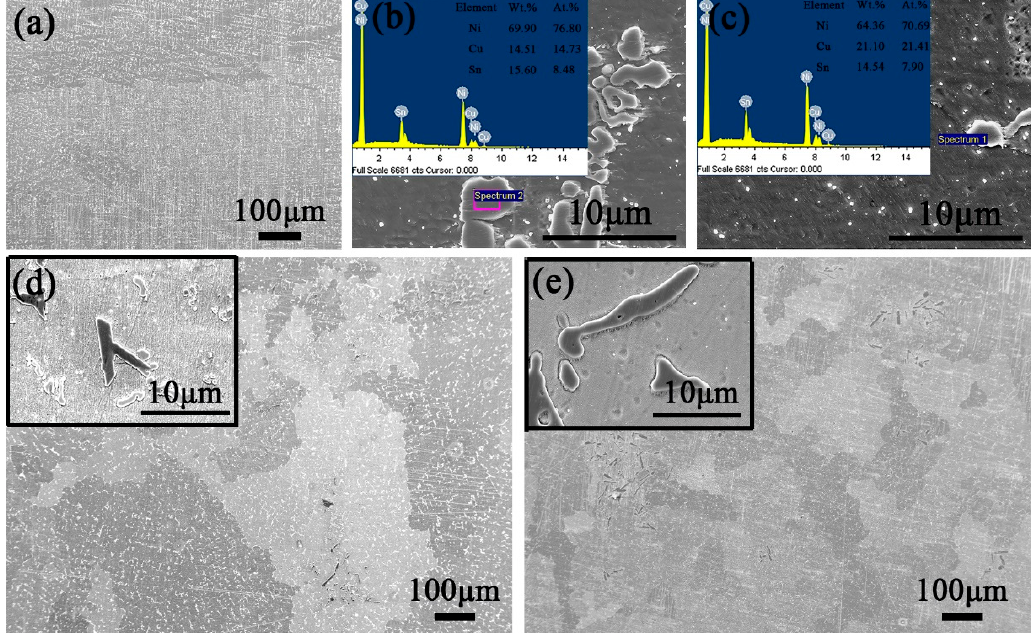
Figure 9. The SEM images of solid solution microstructure for Cu–15Ni–8Sn–xMo alloys with dif- ferent Mo content: ( a – c ) x = 0.3, ( d ) x = 0.9, ( e ) x = 1.5 wt.%.